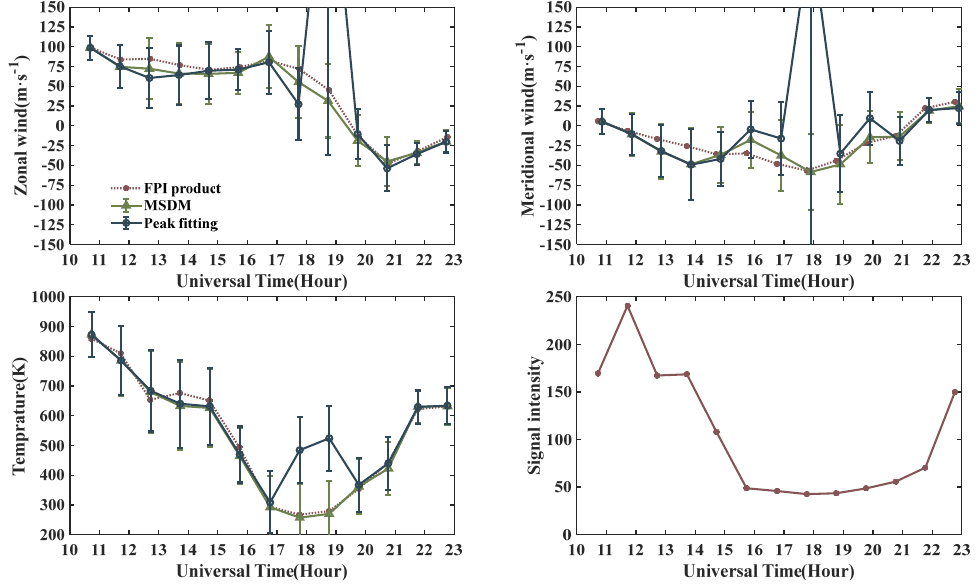
Figure 10. Inversion with airglow interferograms on day 17 of 2012. Wind and temperature errors and signal intensity provided by FPI products manufactured by NCAR.